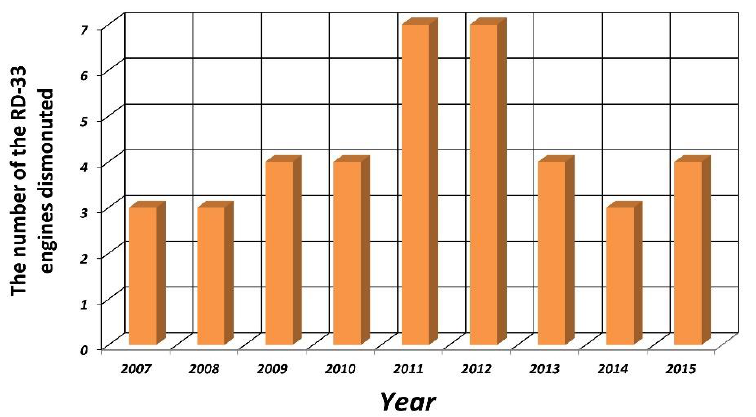
Figure 19. The number of RD-33 engines dismounted from airplanes due to damage to the high- pressure turbine in one of the air bases in Poland during the years 2007–2015 [4].